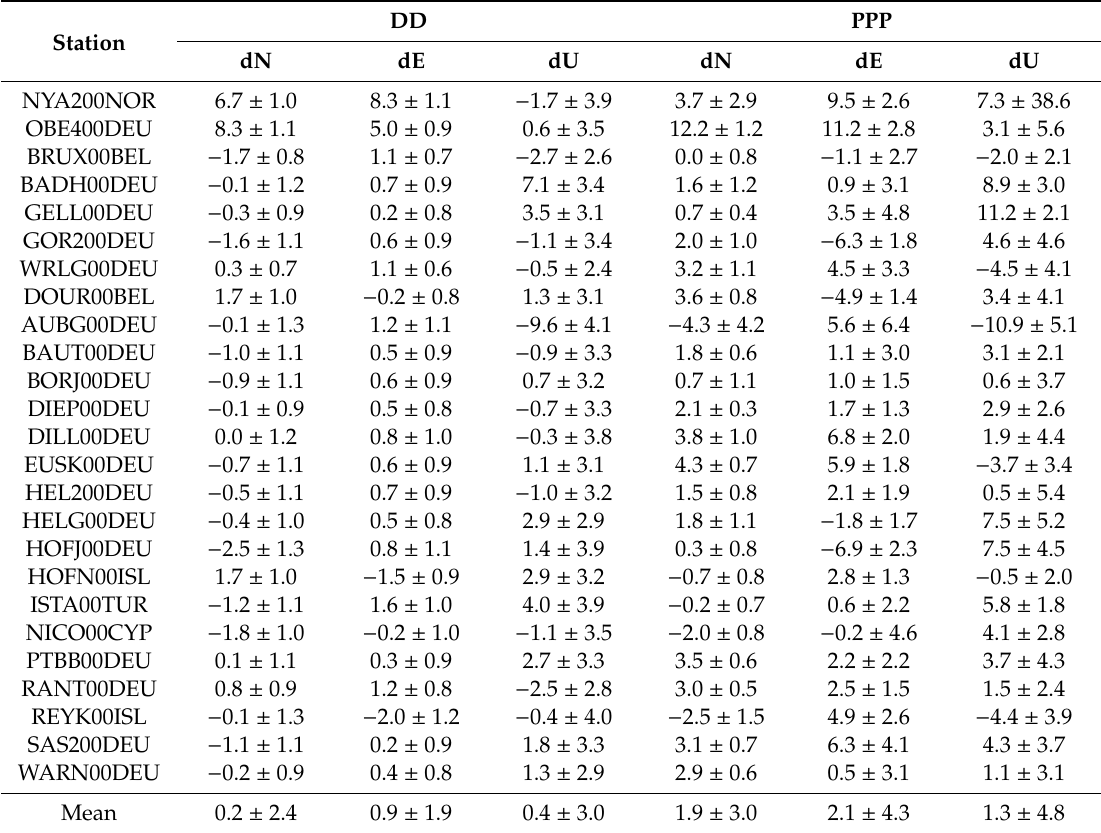
Table A5. Coordinate di ff erences between solution E3 and G2 (G2 minus E3) and their standard deviations. All values in